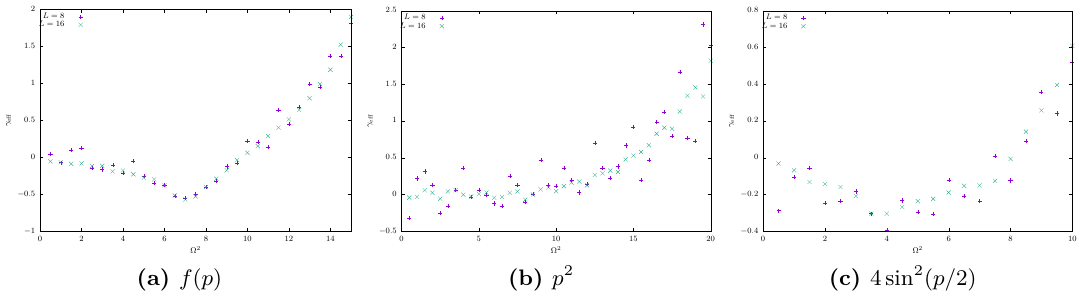
Figure 3. Free-theory results for the effective anomalous dimension γ eff obtained from using eq. (3.3) to fit the analytic mode number over the window [Ω 2 , Ω 2 + 1] . Each plot compares L 4 lattice volumes with L = 8 and 16 , using periodic BCs. The left plot shows the A ∗ using f ( p ) from eq. (2.5). The center plot considers instead a naive continuum-like discretization of the free operator in momentum space, while the right plot corresponds to the hypercubic-lattice dispersion relation 4 sin 2 ( p/ 2)